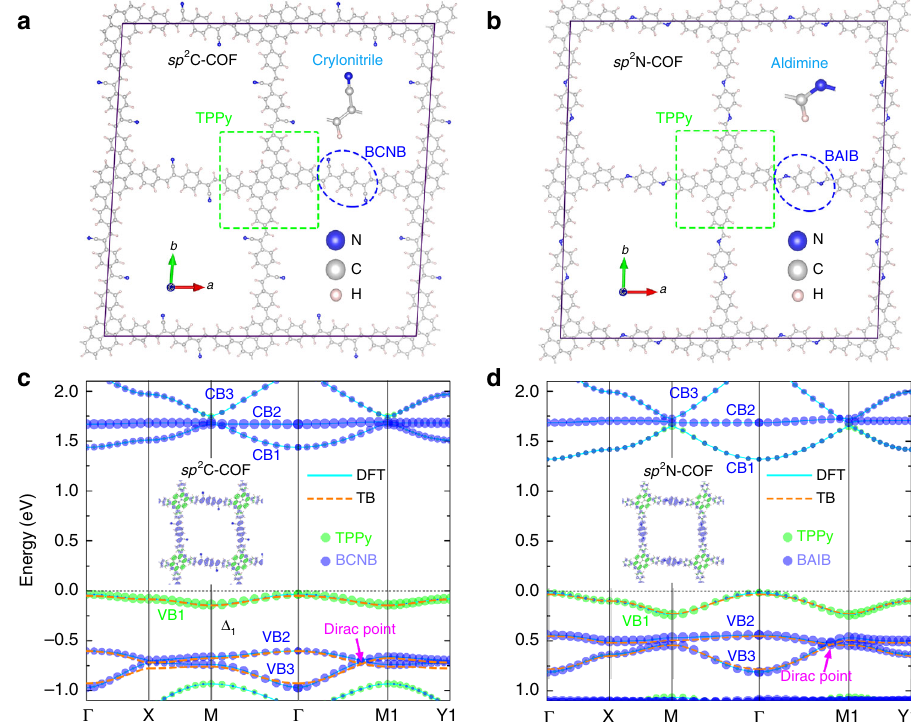
Fig. 3 Realization of distorted Lieb lattices in COFs. Top views of ( a ) sp 2 C-COF and ( b ) sp 2 N-COF in a 2 × 2 supercell. The corner (TPPy) and edge (BCNB or BAIB) ligands are marked by the green-dashed squares and blue-dashed ellipses, respectively. Insets: Enlarged structures of end groups on the edge sites, i.e., crylonitrile for BCNB and aldimine for BAIB. c and d Projected band structures of monolayer sp 2 C-COF and sp 2 N-COF, respectively, where the green and blue circles (the sizes represent the weight of MOs) indicate that the states are contributed by corner (TPPy) and edge (BCNB or BAIB) sites, respectively. Insets: Partial charge distributions of top three valence bands. Orange dashed-lines in ( c ) and ( d ): TB fi ttings of DFT band structures based on distorted Lieb lattice model for these top three valence bands. In ( c ) sp 2 C-COF: t 1 ¼ 0 : 1 eV ; t 2 ¼ 0 : 4 t 1 ; t 3 ¼ 0 : 45 t 2 ; dE ¼ 5 : 9 t 1 ; in ( d ) sp2C-COF: